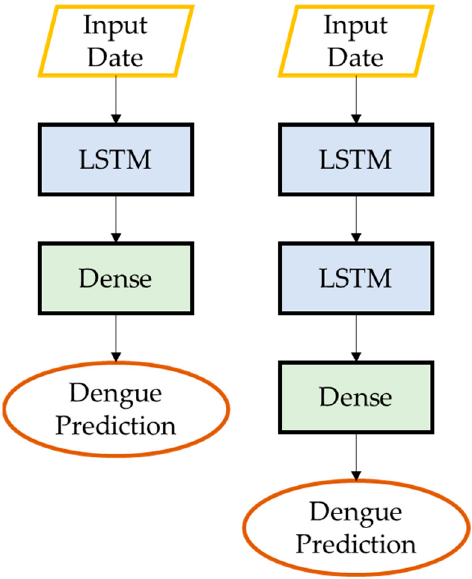
Figure 5. Architecture of LSTM and S-LSTM.